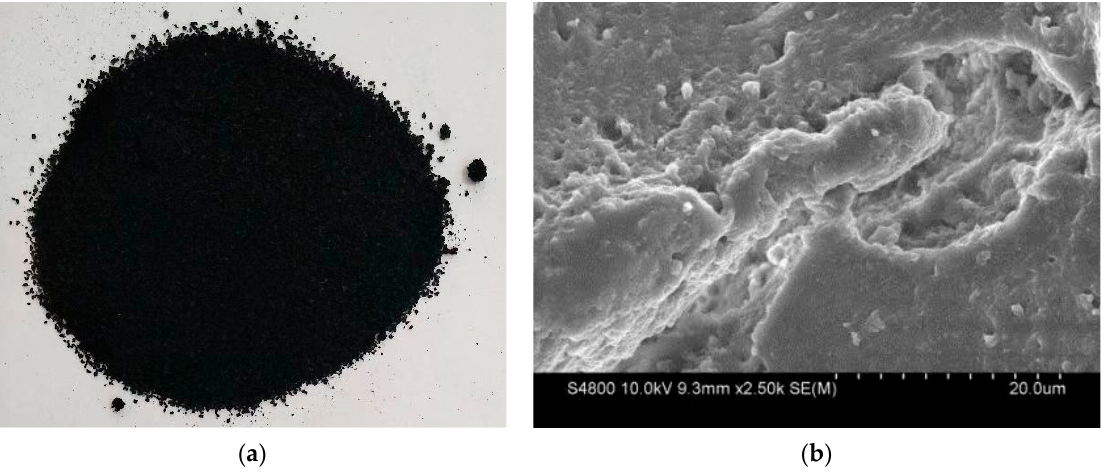
Figure 1. Crumb rubber used in this study: ( a ) original appearance; ( b ) SEM.